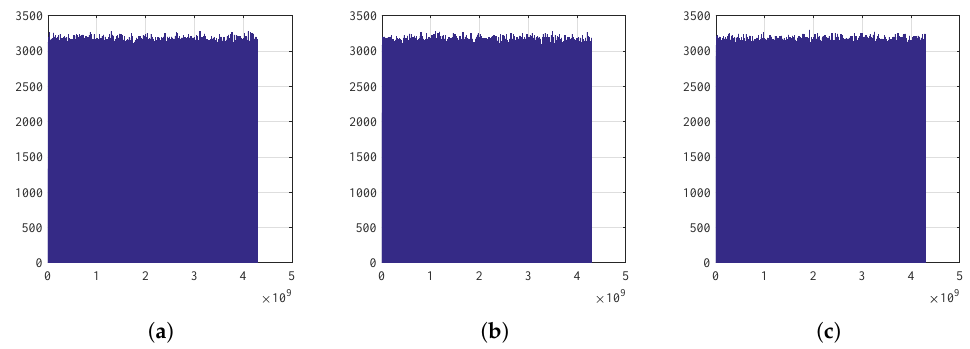
Figure 10. Histograms of the produced sequences X1, X2, and X3 by LSP-PRNG, LST-PRNG, and LSPT-PRNG respectively. ( a ) The histogram of the produced sequence X1. ( b ) The histogram of the produced sequence X2. ( c ) The histogram of the produced sequence